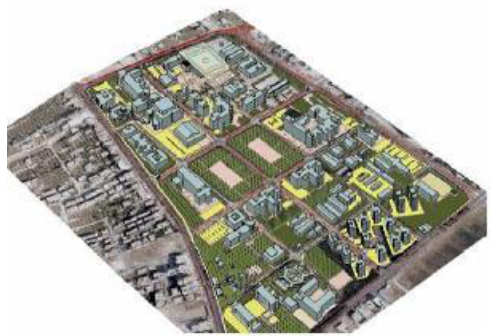
Fig.4- 3-D Model for Yarmouk University (source: Al-Hanbali et al., 2006)